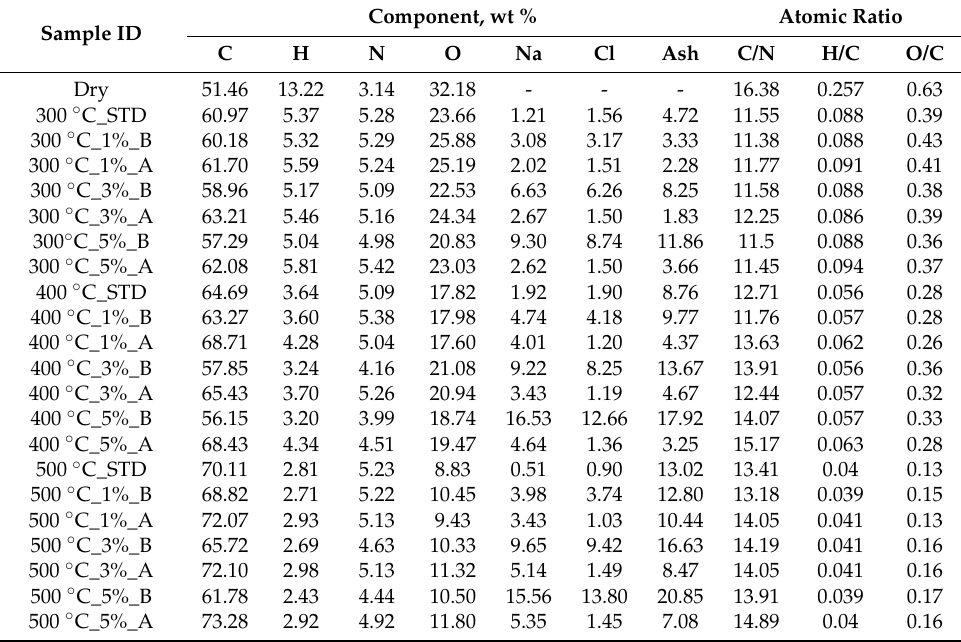
Table 2. The chemical compositions and atomic ratios of biochar produced by salty food waste. Sample